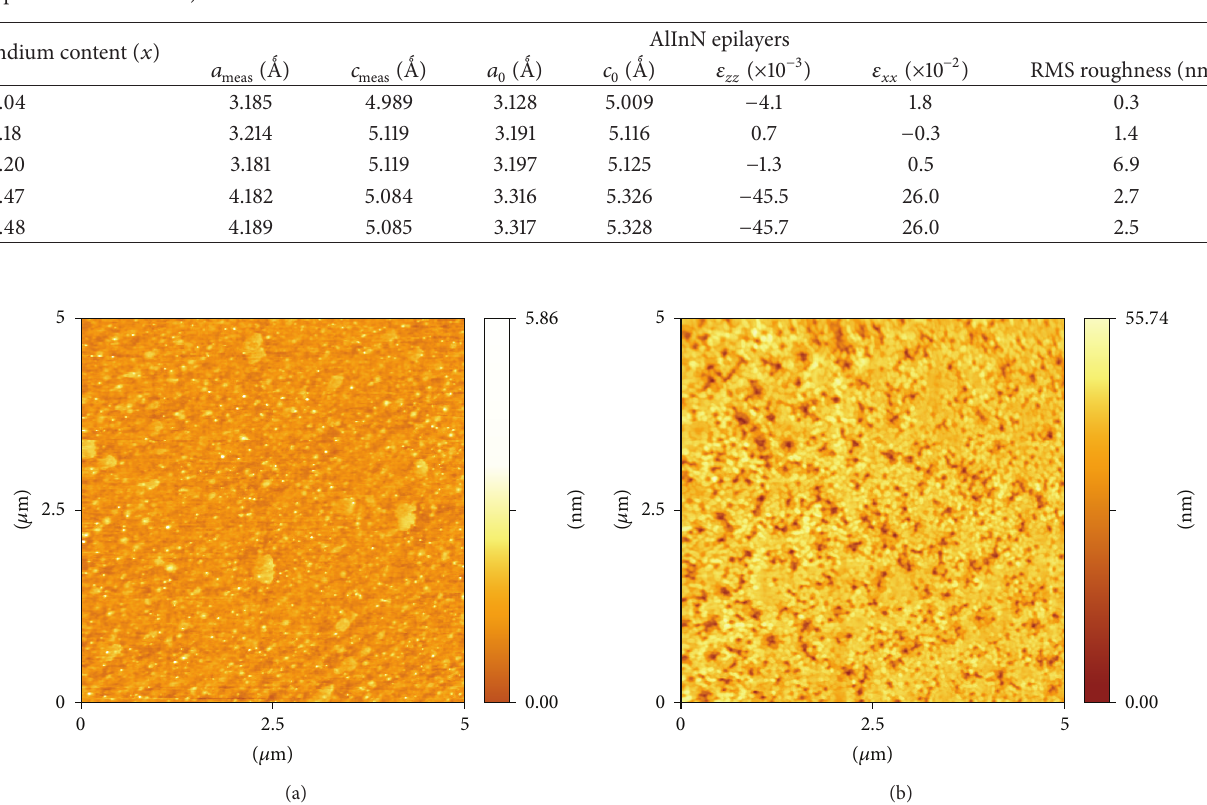
Figure 2: AFM images (5 × 5 𝜇 m 2 scan) of AlInN layers in (a) sample A and (b) sample